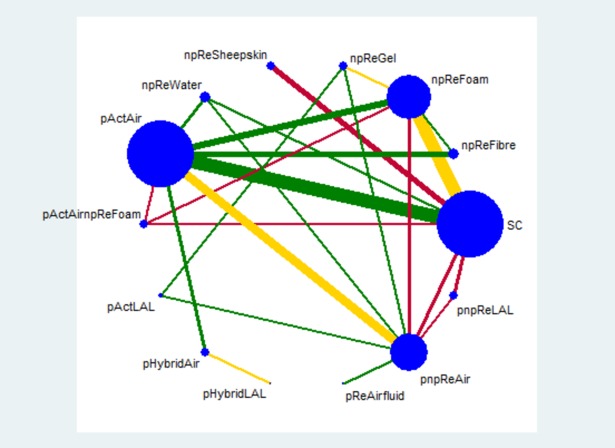
Network plot for the incidence of pressure ulcers produced by STATA networkplot command.Fourteen intervention groups are coded in the plot (i.e., nodes): SC = standard hospital surfaces, npReFibre = non-powered reactive fibre surfaces, npReFoam = non-powered reactive foam surfaces, npReGel = non-powered reactive gel surfaces, npReSheepskin = non-powered reactive sheepskin surfaces, npReWater = non-powered reactive water surfaces, pActAir = powered active air-cells surfaces, pActAirnpReFoam = powered active air-cells surfaces plus non-powered reactive foam surfaces, pActLAL = powered active low-air-loss air surfaces, pHybridAir = powered hybrid air-cells surfaces, pHybridLAL = powered hybrid low-air-loss air surfaces, pReAirfluid = powered reactive air-fluidised surfaces, pnpReAir = powered or non-powered reactive air-cells surfaces, and pnpReLAL = powered or non-powered reactive low-air-loss air surfaces. Each node size is proportional to the number of direct comparisons involving each intervention group. Taking any two of the six nodes forms 91 network contrasts. 24 lines between nodes represent direct comparisons driven by RCTs; and line thickness is proportional to the number of studies involved in each direct comparison. Direct evidence of two or more comparisons can generate indirect evidence for contrasts that did not involve a head-to-head RCT (e.g., indirect evidence for the comparison of npReFoam vs. npReWater generated from comparisons, for example, of npReFoam vs. SC and npReWater vs. SC). In this way, indirect evidence informs the remaining 67 of the 91 network contrasts. The risk of bias assessment was based on the most frequent level of bias recorded for studies included in that comparison and denoted using coloured lines (or links). A green link indicates no serious study limitations; yellow indicates serious limitations; and red indicates very serious limitations.